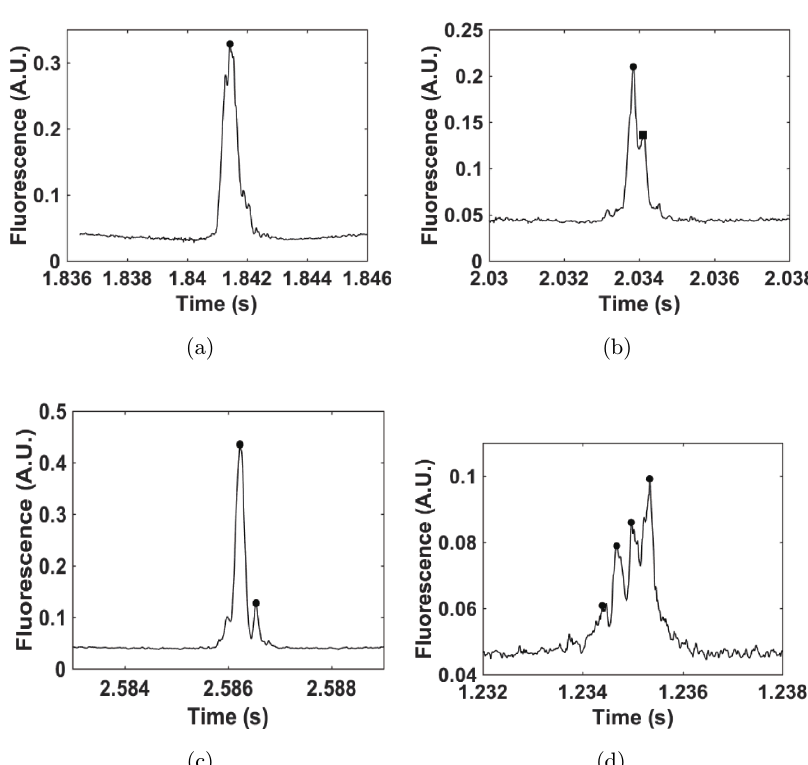
Fig. 4. Cell cluster identi¯cation using proposed algorithm based on Rayleigh criterion. (a) Typical data trace for single circulating tumor cell. Circle indicates position of local maximum. (b) Single cell signal identi¯ed by proposed algorithm. Square indicates local maximum, which is not considered an e®ective signal for cell. (c) Typical signal of cell cluster with dual cells. (d) Another typical signal of CTC cluster identi¯ed with proposed algorithm. This group of peaks indicates that this cell cluster consists of four cells. A.U. denotes arbitrary